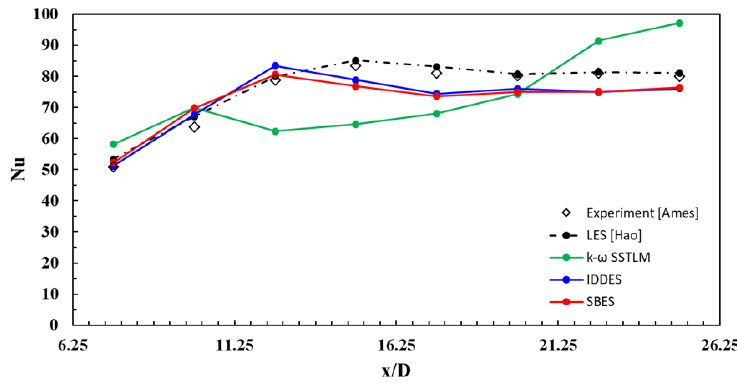
Figure 9. Averaged pin Nusselt numbers of pins along line C.